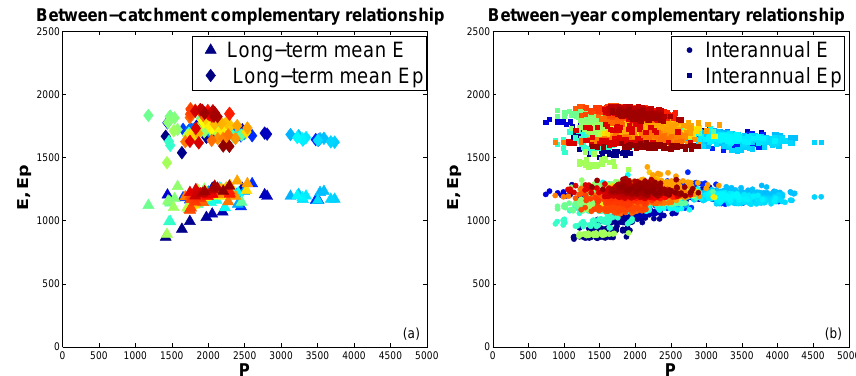
Figure 7. (a) Between-catchment and (b) between-year complementary relationships for the 146 sub-catchments of the Amazon River basin.